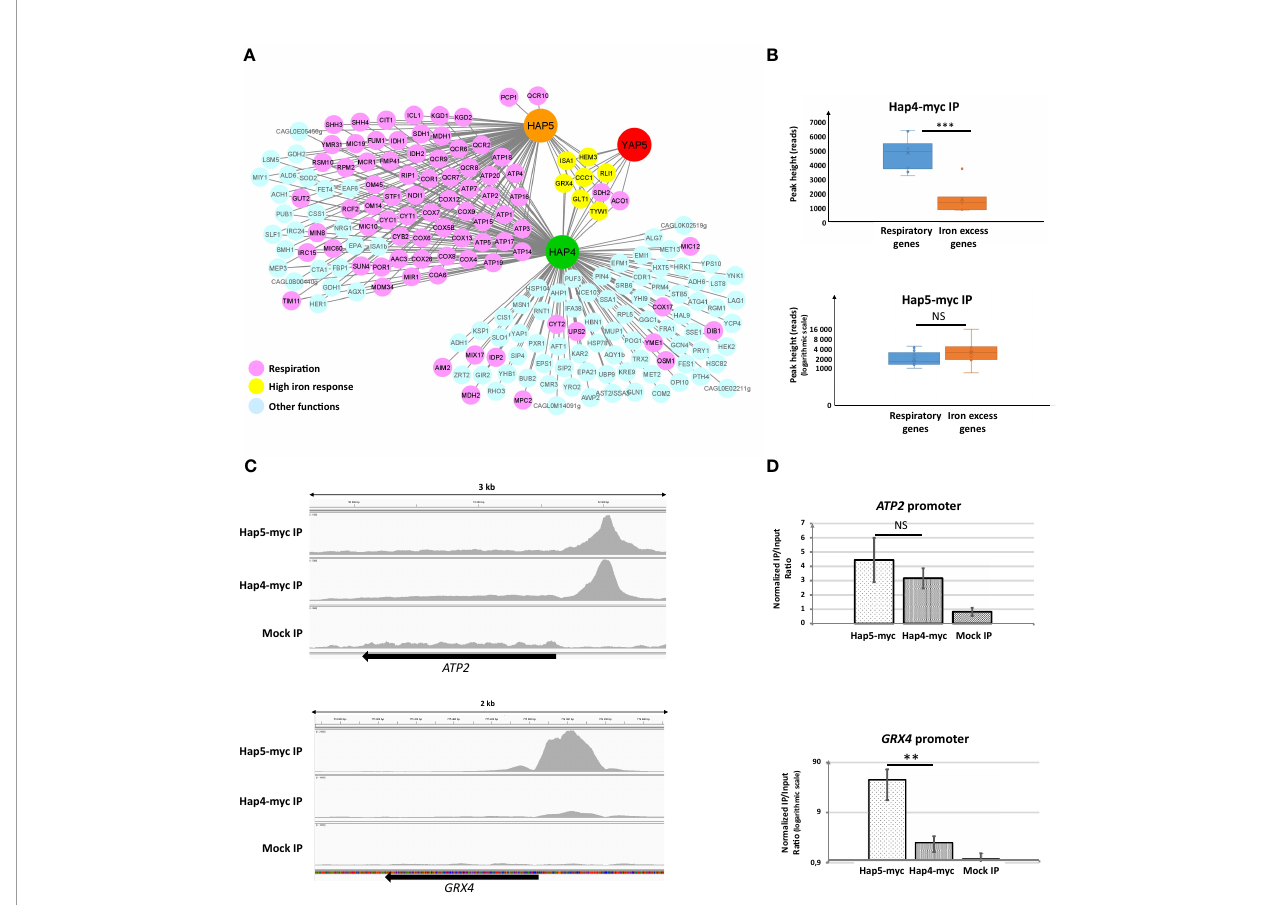
FIGURE 3 | ChIP analyses of Hap4 targets. (A) The Hap4-Hap5-Yap5 regulatory network. An arrow indicates a potential regulatory interaction based on ChIP-seq results. The color of the targets indicates their belonging to respiratory pathways (pink), high iron response (yellow) or other pathways (light blue). The Yap5 data are from Thie ́ baut et al., 2017. The gene names indicated are either the of fi cial C. glabrata names or those of the S. cerevisiae orthologs, according to the CGD database (www.candidagenome.org). This representation was made using Cytoscape (Shannon et al., 2003). (B) Box plots of the maximal height of ChIP peaks (expressed in reads counts) corresponding to the 10 best respiratory targets ( SDH1 , ATP2 , FUM1 , RPM2 , CYT1 , COX4 , COX5B , QCR8 , ATP5, ATP3 ) (blue box plots) or the high iron tolerance genes ( GRX4 , CCC1 , HEM3 , TYW1 , ISA1 , RLI1 , GLT1 ) (orange box plots) of Hap4 (upper panel) or Hap5 (lower panel). For the results from Hap5 IP, a logarithmic scale was used to improve the readability of the fi gure. The result of a t-test comparing the respiratory and iron excess genes box pots in Hap4-myc and Hap5-myc IPs is symbolized as follows: ***p < 0.01, NS: p > 0.1. (C) IGV snapshots of the ChIP peaks obtained for Hap5 and Hap4 IPs at the promoters of ATP2 (upper panel) and GRX4 (lower panel). The Y axis scales have been adjusted so that the local background (= read counts in the body of the genes) appears similar in the different lanes. The pro fi le for the mock IP experiment (wild type, untagged strain) is also indicated. (D) ChIP-qPCR was performed on strains expressing either a myc-tagged Hap5 (Hap5-myc) or Hap4 (Hap4-myc). All strains were grown in glycerol media. The values on the histograms represent the IP/Input ratios of the ATP2 (upper panel) or GRX4 (lower panel) promoters relative to the enrichment of the ACT1 promoter (used as an internal control). For GRX4 , a logarithmic scale was used to improve the readability of the fi gure. The experiments were performed four times on biologically independent samples. Error bars hence represent the standard error of the mean. The result of a t-test comparing the Hap4-myc and Hap5-myc enrichments is symbolized as follows: **p < 0.05, NS: p >